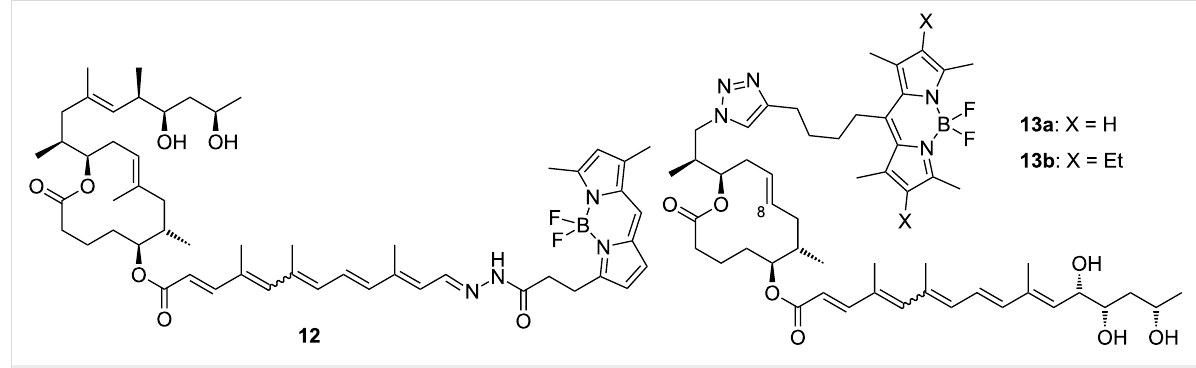
Figure 5: Fluorescent probes derived from natural mycolactone A/B ( 1a , b ) or its synthetic 8-desmethyl analogs ( 13a,b ).